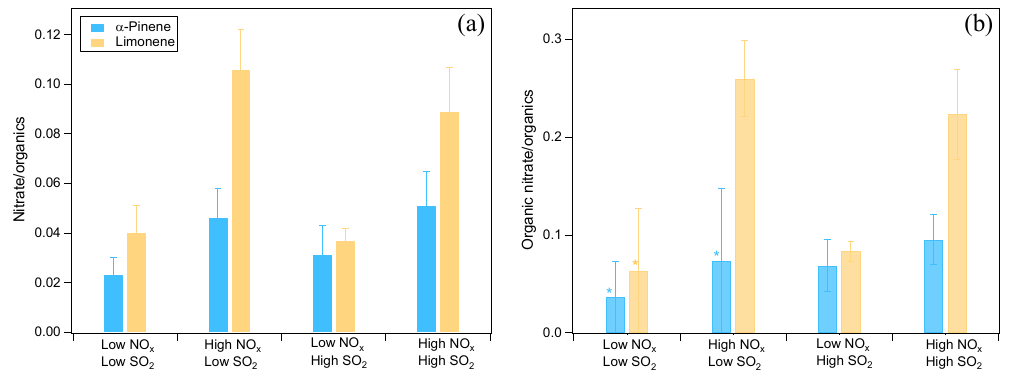
Figure 4. (a) The ratio of nitrate mass concentration to organics mass in different NO x and SO 2 conditions. The average ratios of nitrate to organics during the reaction are shown and error bars indicate the standard deviations. (b) The fraction of organic nitrate to total organics in different NO x and SO 2 conditions calculated using a molecular weight of 200gmol − 1 for organic nitrate. The average fractions during the reaction are shown and error bars indicate the standard deviations. In panel (b) , ∗ indicates the experiments where the ratios of NO + were too noisy to derive a reliable fraction of organic nitrate. For these experiments, 50% of total nitrate was assumed to be organic nitrate and the error bars show the range when 0 to 100% of nitrate is assumed to be organic nitrate.